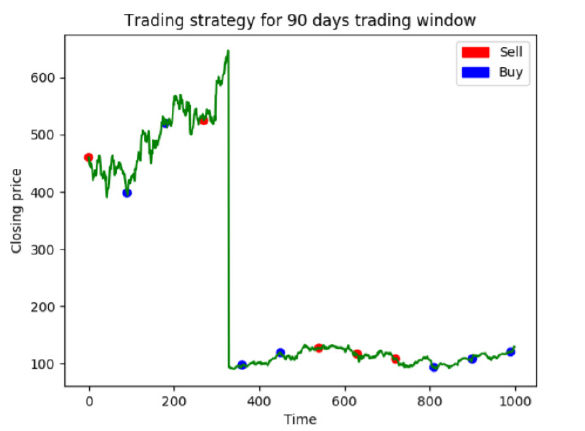
Figure 6 : Comparison of the accuracy achieved in this work to the accuracies achieved in available literature